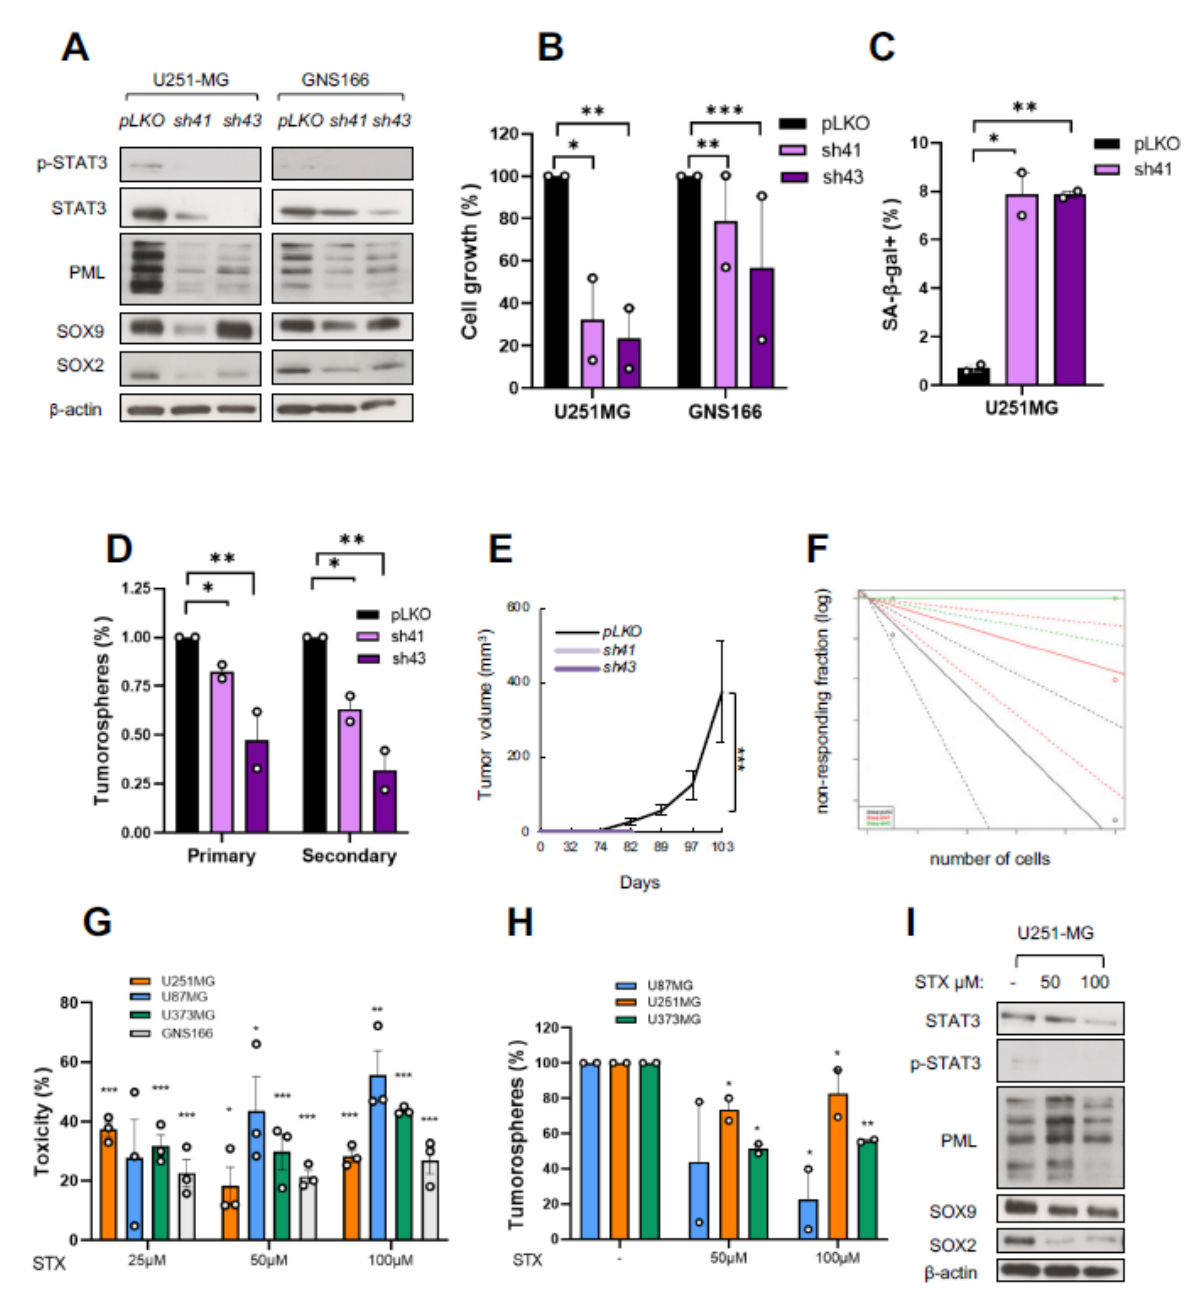
Figure 5. Genetic and pharmacological STAT3 inhibition in glioma cells: ( A ) representative im- munoblots of p-STAT3, STAT3, PML, SOX9, and SOX2 in U251-MG and GNS166 cells in STAT3 knockdown (“ sh41 ” and “ sh43 ”) and control (“ pLKO ”) cells ( n = 3); ( B ) quantification of cell growth in sh41 and sh43 cells compared with controls ( n = 2); ( C ) quantification of SA- β -gal + cells in STAT3 knockdown cells ( n = 2); ( D ) quantification of tumorspheres (primary and secondary) in sh41 and sh43 U251-MG cells relative to pLKO condition ( n = 2); ( E ) tumor volume representation at indicated time points after subcutaneous injection of U251-MG cells ( n = 4); ( F ) ELDA plot of limiting dilution assay of sh41, sh43 , and control U251-MG cells; ( G ) cytotoxicity exhibited by indicated glioma cells after treatment with increasing doses of STX-0119 for 72 h ( n = 6); ( H ) quantification of tumorspheres in indicated cells after treatment with 50 and 100 µ M STX-0119 ( n = 3). Calculations were relative to untreated cells; ( I ) representative immunoblot of p-STAT3, STAT3, PML, SOX9, and SOX2 expression in U251-MG cells after treatment with 50 and 100 µ M STX-0119 for 72 h ( n = 3). * p < 0.05, ** p < 0.01, *** p <